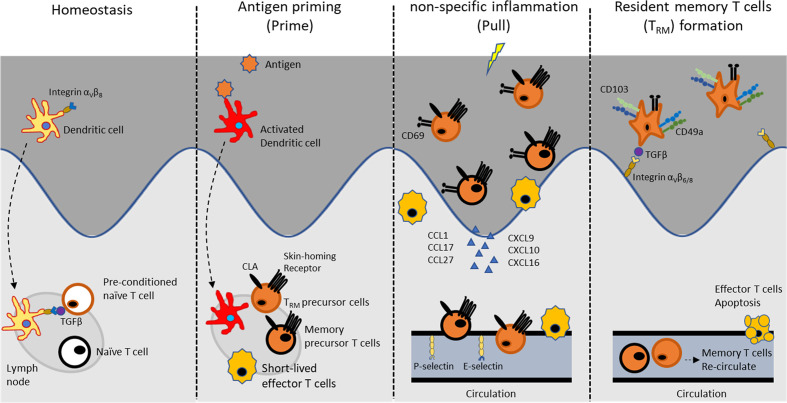
Development of skin TRM cell.